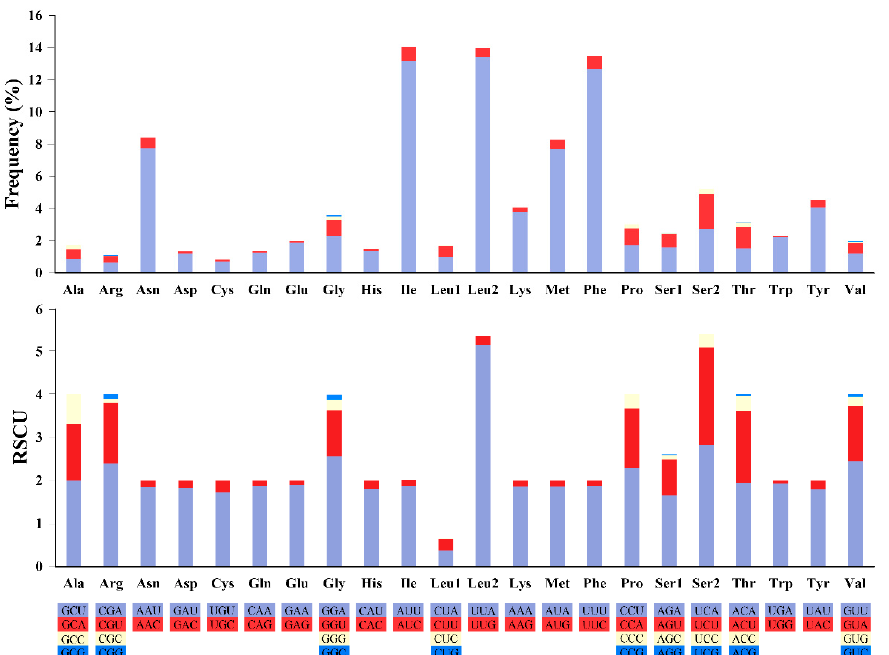
Figure 5. Codon usage in the mitochondrial genome of Stomaphis sinisalicis . The bar chart above indicates codon usage frequency of amino acids used for construction of 13 protein coding genes; and the bar chart below represents the relative synonymous codon usage (RSCU) of mitochondrial protein-coding genes. Codon families are labeled below the X-axis.